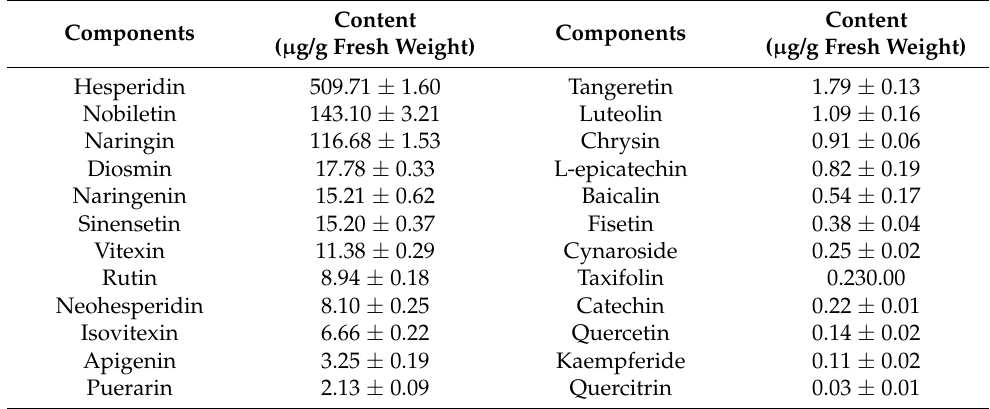
Table 7. The concentration of the specific phenols and flavonoids contained in the